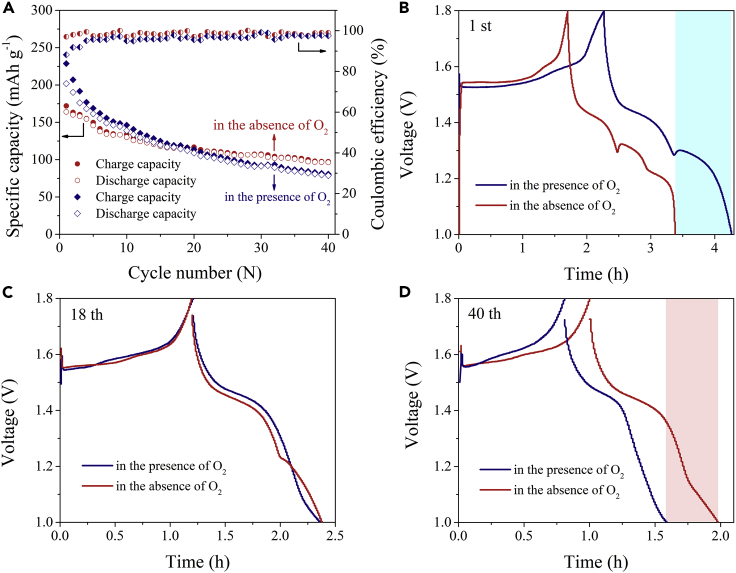
Electrochemical Characterization of Aqueous Zn-MnO2 Batteries(A) Cycling stability at 0.1 A g−1 in the presence of O2 and in absence of O2.(B–D) Galvanostatic charge and discharge (GCD) curves at different cycles: (B) the first cycle, (C) the 18th cycle, and (D) the 40th cycle.